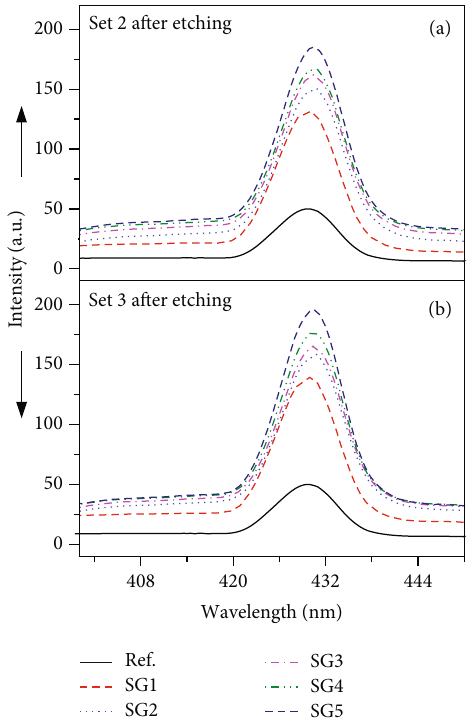
Figure 7: Absorption spectra of (a) set 2 and (b) set 3 after etching at 70 ° C for 3 hrs.